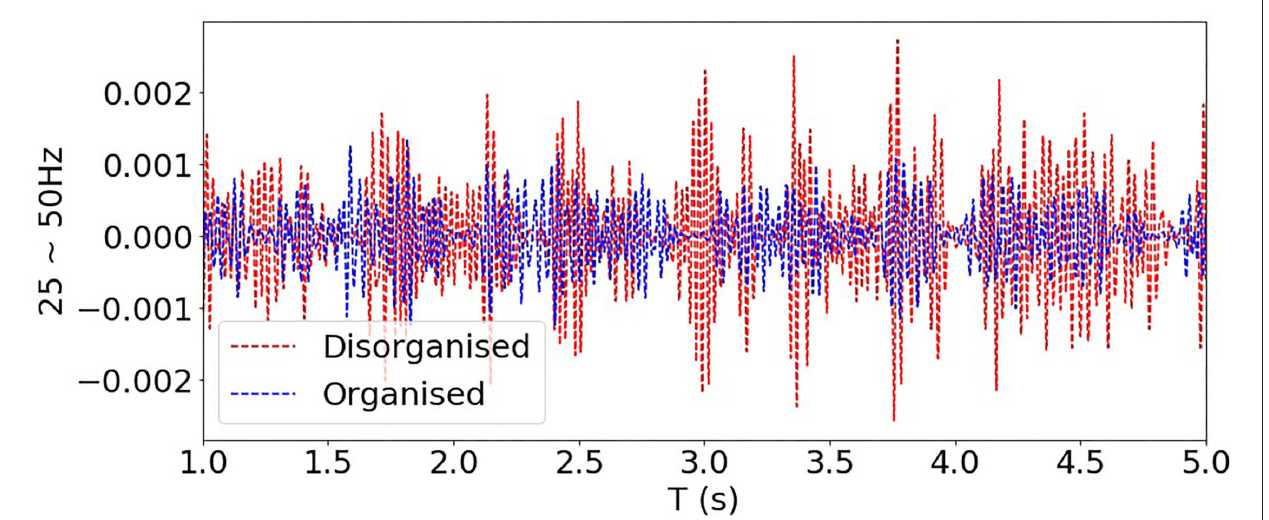
FIGURE 9 | Comparing filtered signals of bands 25 ∼ 50 Hz from one organised and one disorganised subjects (clinical AF